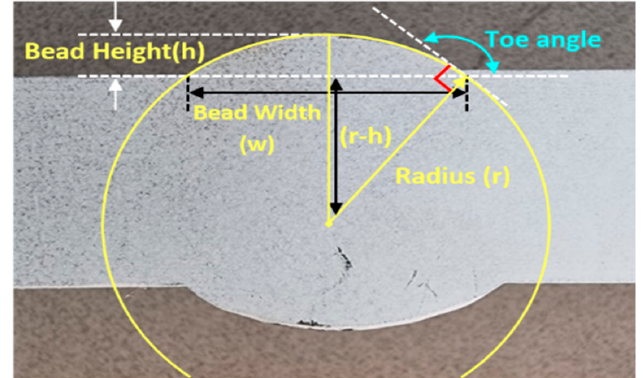
22 of 25 Figure 26. K (cid:2930) × K (cid:2923) at the fracture location for each test number. A value of 2.6 for K (cid:2930) × K (cid:2923) can be used as a borderline SCF to confirm whether the fatigue limit (stress at 10 (cid:2875) cycles) can satisfy the E curve requirements of the BV rule or not. It can also be concluded that the K (cid:2923) × SCF may be used as a new index to decide whether the fatigue limit can meet a specific fatigue limit of the fatigue curve or not, es- pecially the E curve requirements of the BV rule.